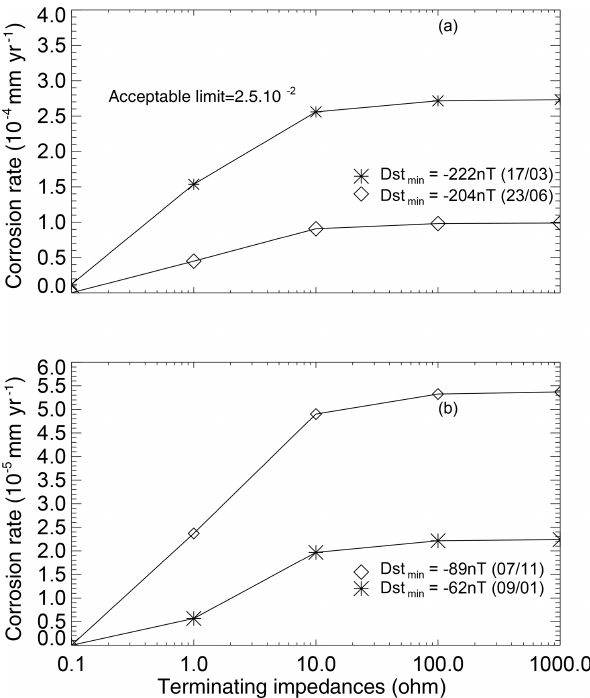
Figure 6. Corrosion rate as a function of the terminating impedances for strong (a) and moderate (b) geomagnetic storms. The acceptable limit of corrosion is indicated in (a) .